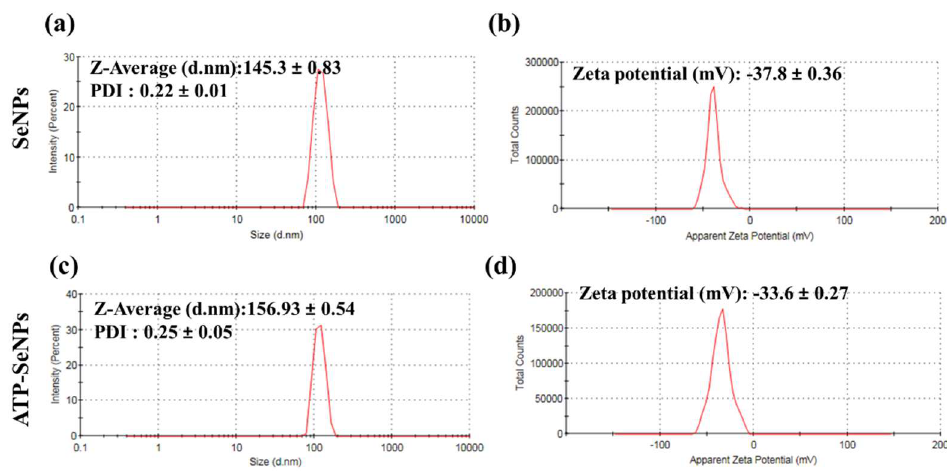
Figure 4. Dynamic light scattering (DLS) analysis of SeNPs and ATP-SeNPs. Zeta size and potential of SeNPs ( a , b ) and ATP-SeNPs ( c , d ).